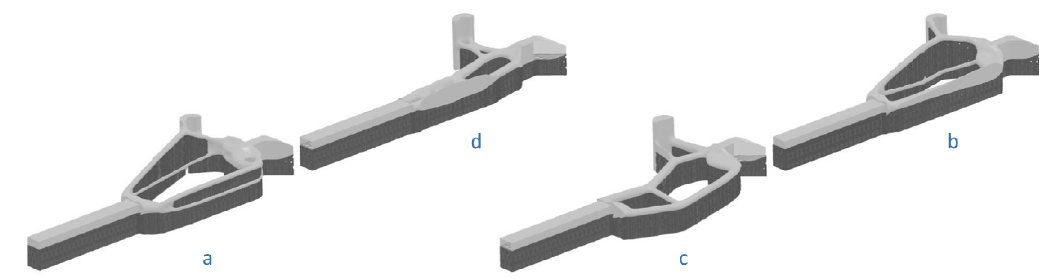
Figure 10. Industrialisation study of concepts ( a – d ).